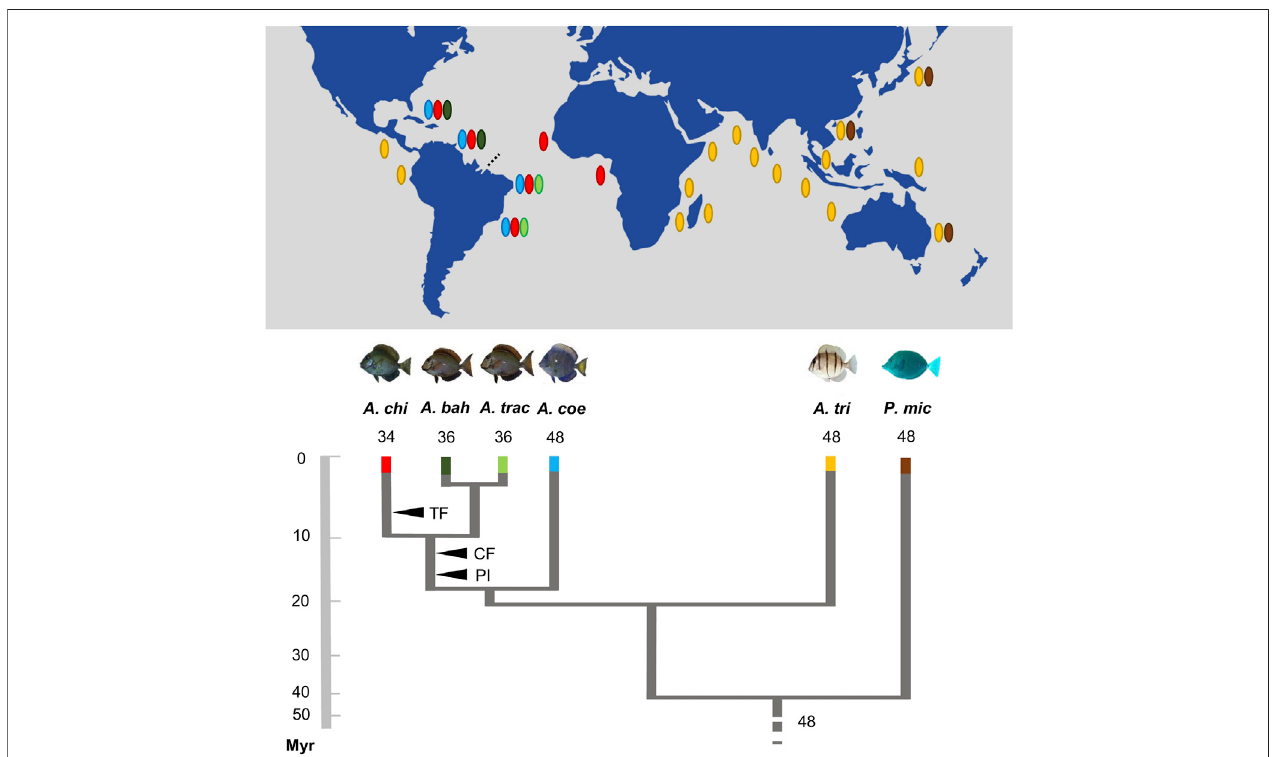
FIGURE 5 | Karyotype diversi fi cation, phylogenetic relationships, and schematic geographic distribution of the Acanthurus species analyzed. The black arrowheadsindicatesharedandexclusivechromosomalrearrangementsintheAtlanticspecies(CF:sixcentricfusionsevents;PI:threepericentricinversionsevents;TF: in tandem fusion) regarding their phylogenetic diversi fi cation (adapted from Bernal and Rocha, 2011; Sorenson et al., 2013). The dotted line highlights the Amazonas River plume. The names of the species are identi fi ed by abbreviations - Acanthurus chirurgus (A. chi); Acanthurus bahianus (A. bah); Acanthurus tractus (A. tra); Acanthurus coeruleus (A. coe); Acanthurus triostegus (A. tri); Prionurus microlepidotus (P. mic) .